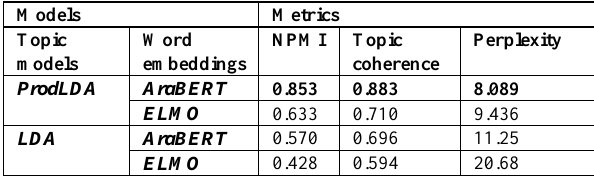
Table 2 . The comparison result of topic models with different embedding models on the collected dataset.